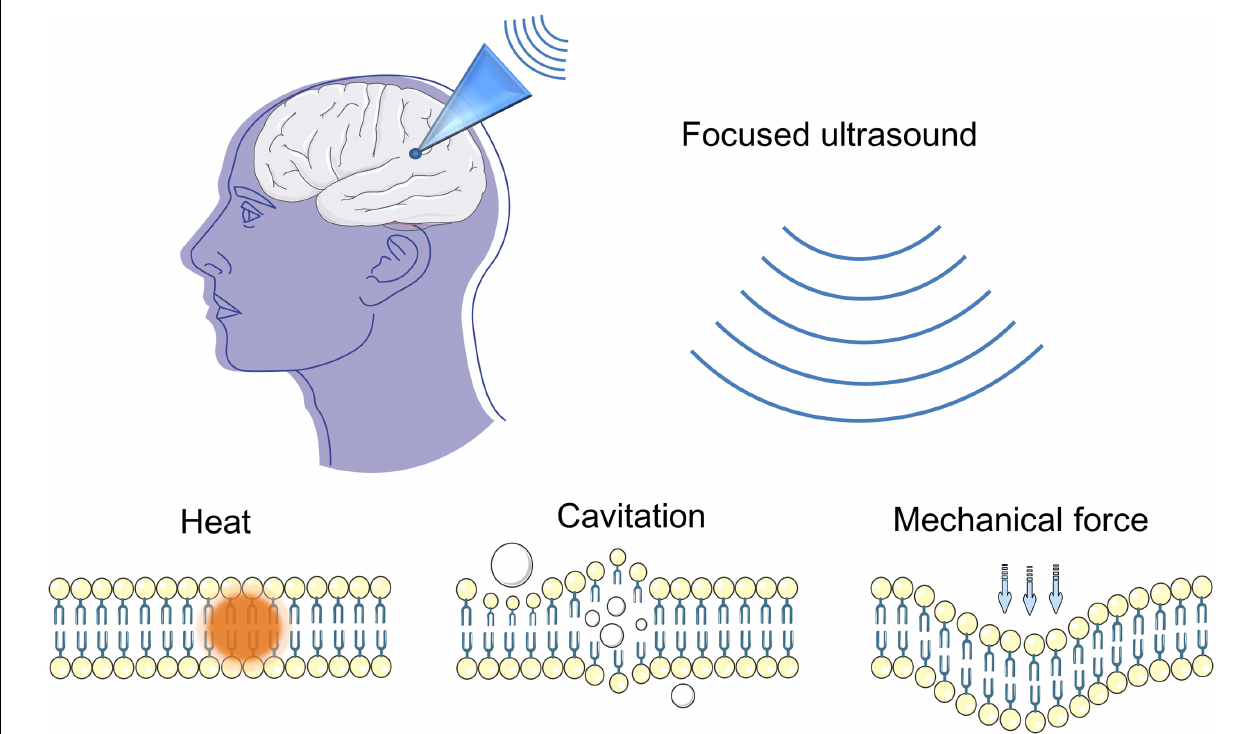
FIGURE 1 | Focused ultrasound neuromodulation. The potential biophysical effects of ultrasonic